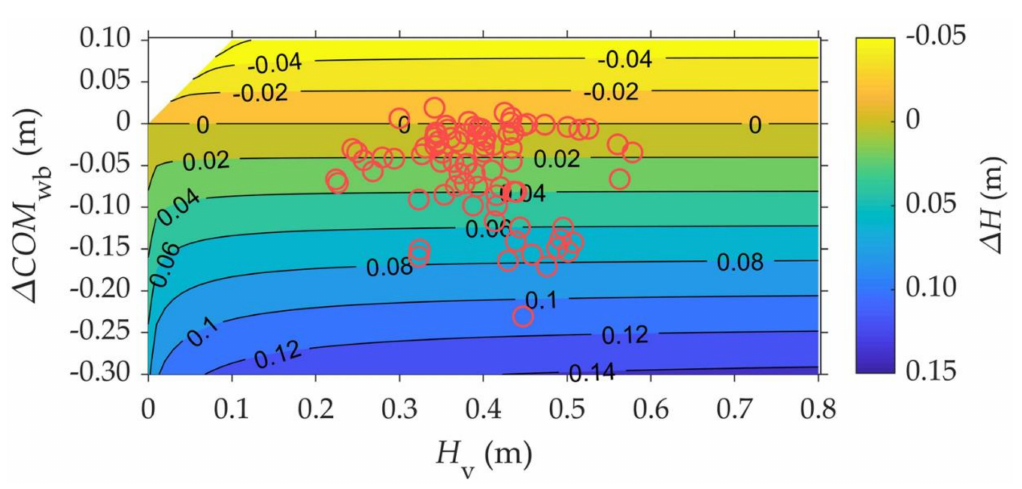
Figure 5. An illustration of the influence of the di ff erence in the COM wb height ( ∆ COM wb ) and jump height ( H v ) on jump height overestimation ( ∆ H ) (Equation (8)). The top-left triangular area in white shows there are no real roots because ∆ COM wb cannot be greater than H v . The red circles represent each experimental data